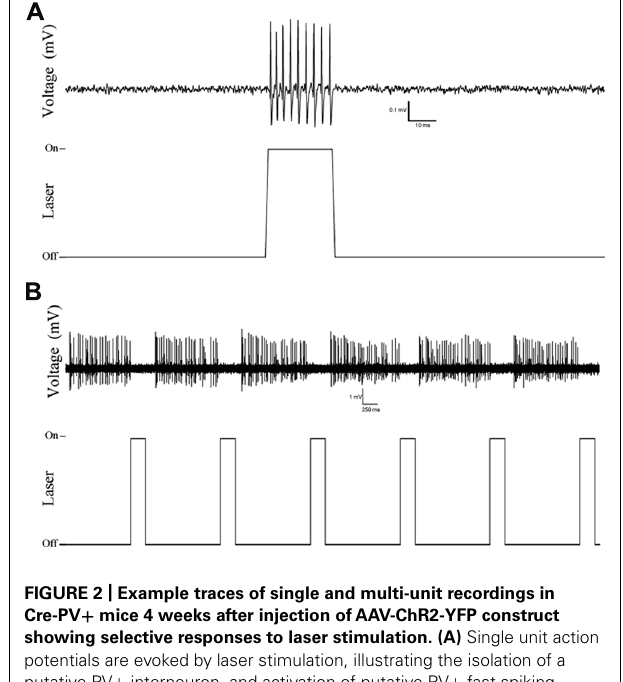
FIGURE 2 | Example traces of single and multi-unit recordings in Cre-PV + mice 4 weeks after injection ofAAV-ChR2-YFP construct showing selective responses to laser stimulation. (A) Single unit action potentials are evoked by laser stimulation, illustrating the isolation of a putative PV + interneuron, and activation of putative PV + fast-spiking interneurons . (B) Multi-unit recording showing inhibition of regular firing units during optical stimulation. (A,B) : top traces are extracellularly recorded potentials (band-pass filtered: 30–300 Hz), bottom traces indicates the timing of optical